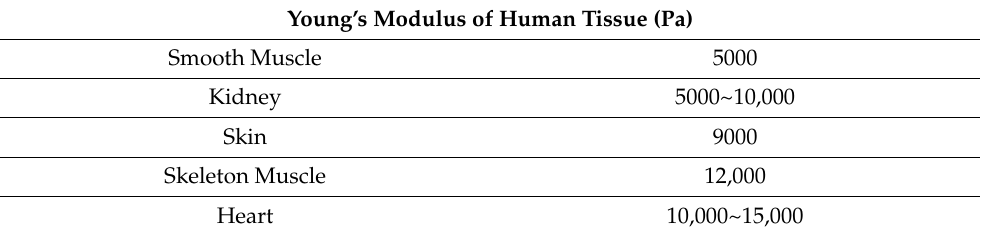
Table 1. Young’s modulus of various tissues of humans [48–50].